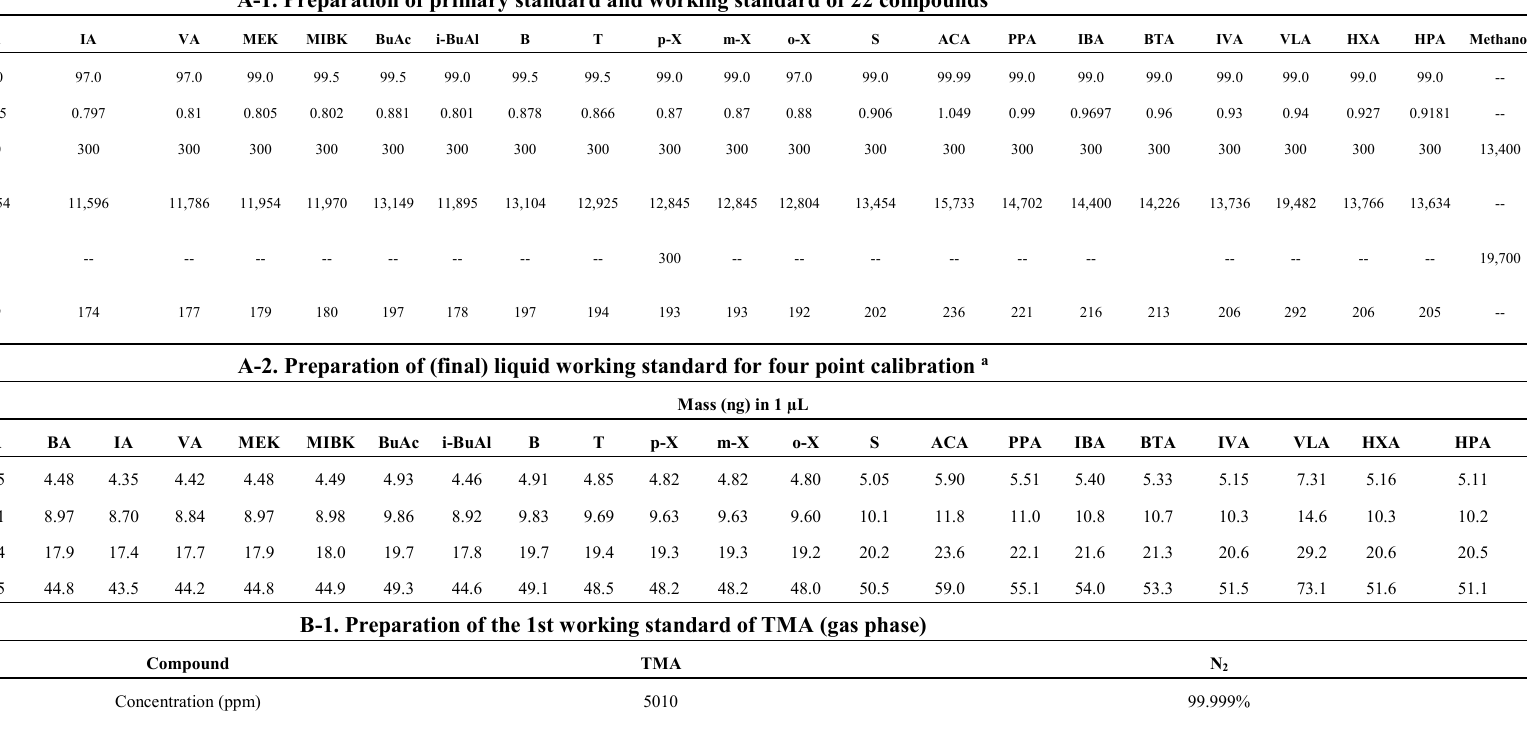
Table 2. Preparation of standards for 23 target compounds (22 in liquid- and one (TMA) in gas-phase). A-1. Preparation of primary standard and working standard of 22